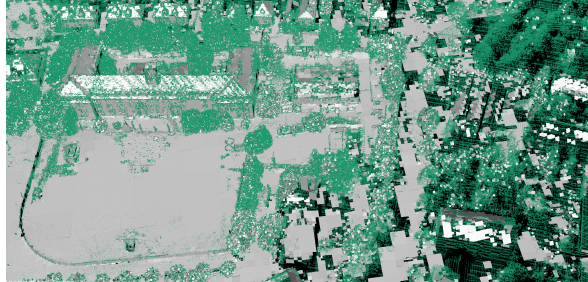
Figure 8. Larger view of the polygon model extended with points in cells without plane, where the outer areas contain only sparse airborne data.